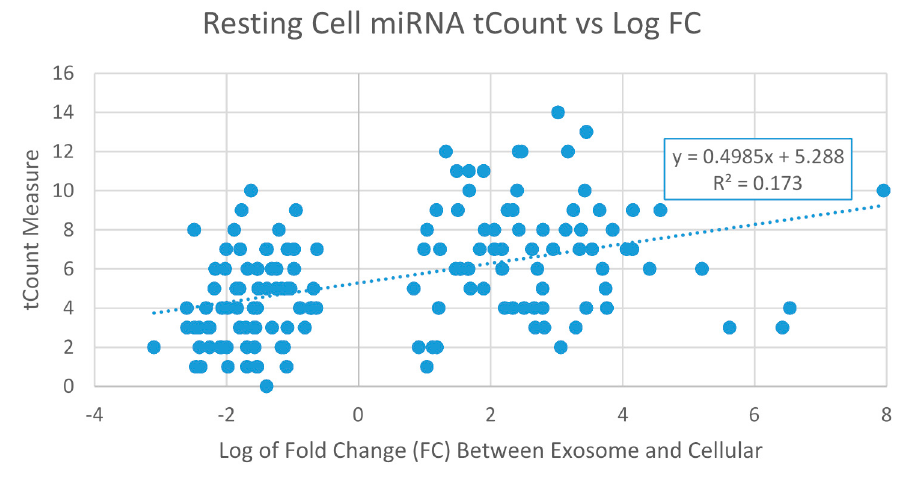
Figure 2. Resting miRNA cell tCount vs. Log fold change between exosome and cellular compartments. Word size was seven nt for calculation for tCount. Trendline added.